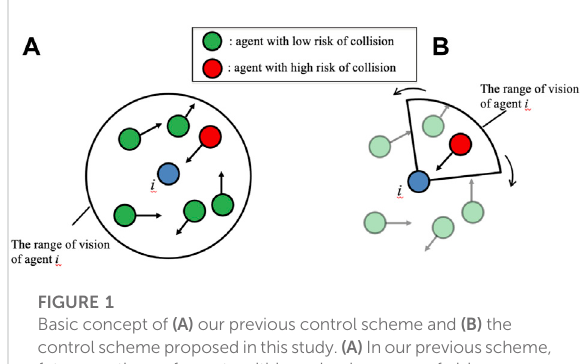
FIGURE 1 Basic concept of (A) our previous control scheme and (B) the controlschemeproposedinthisstudy. (A) Inourpreviousscheme, future motions of agents within a circular range of vision are predicted regardless of the risk of collision (both red and greenagents). (B) Inthecontrolschemeproposedinthisstudy,the range of vision is fan-shaped, and its direction is actively changed. Futuremotionsofagentswithahighriskofcollision(redagent)are predicted, whereas those of the other agents (transparent green agents) are